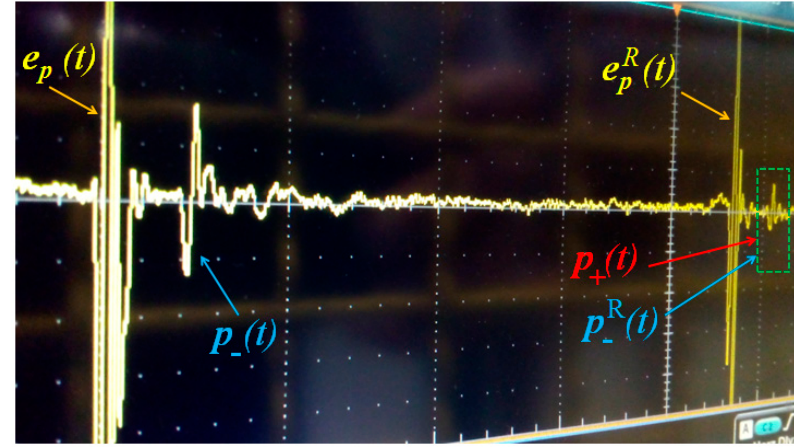
Figure 4. PEA cell output signal depicted by the oscilloscope.